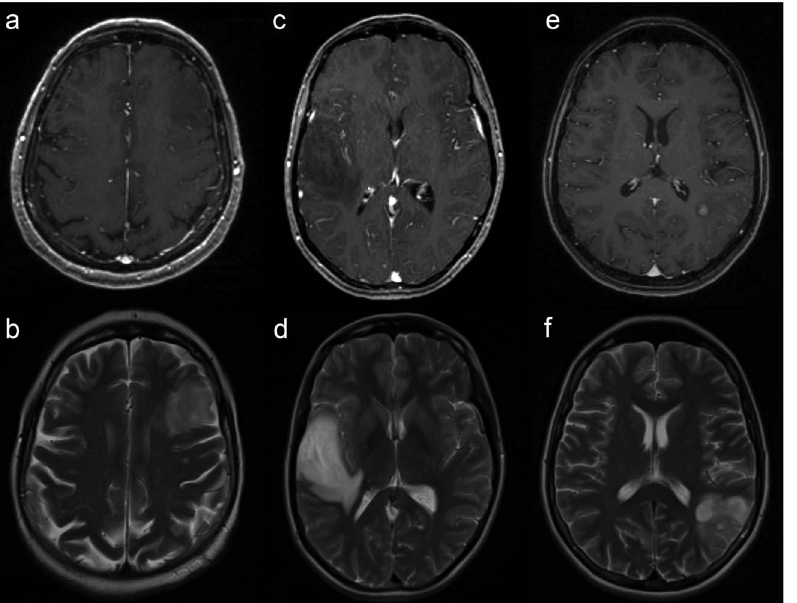
Figure 1. Pattern of contrast-enhancement (CE) on magnetic resonance imaging (MRI) of gliomas with non-significant CE. T1- weighted contrast-enhanced MR images demonstrate examples of gliomas with (a) no visible (= none ) CE, (c) unspecific (= patchy/faint ) CE and (e) a small regional (= focal ) CE in an otherwise non-enhancing tumor. (b,d,f) T2-weighted MR images show the corresponding hyperintense glioma lesions. brain ratio (T/N ratio $ 1.2) defined as PET max as biopsy target [11,17].